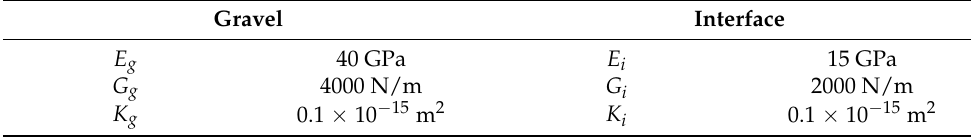
Figure 3. Deflection patterns of the fracture versus the varying of the /